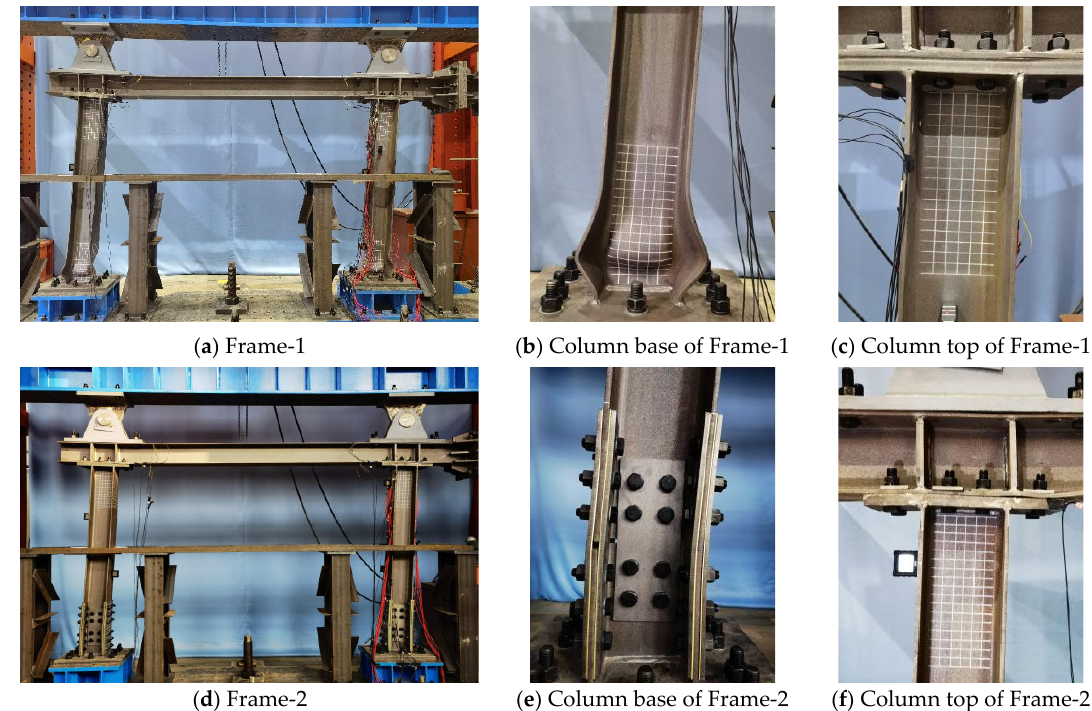
Figure 9. Deformation modes of Frame ‐ 1 and Frame ‐ 2.